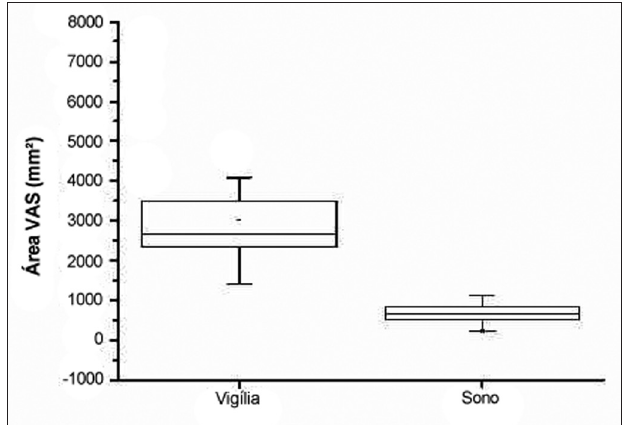
Gráfico 1. Distribuição das medidas de área em mm 2 das VAS na vigília e durante o sono